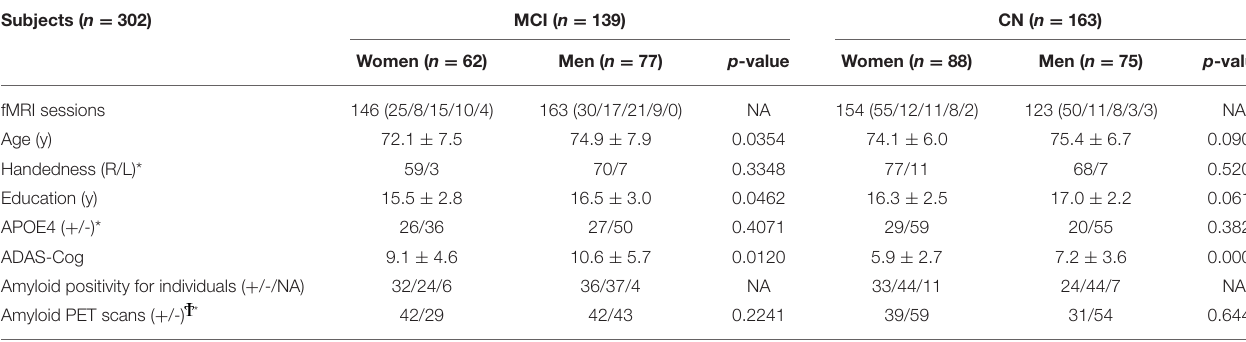
TABLE 1 | Demographic characteristics of study